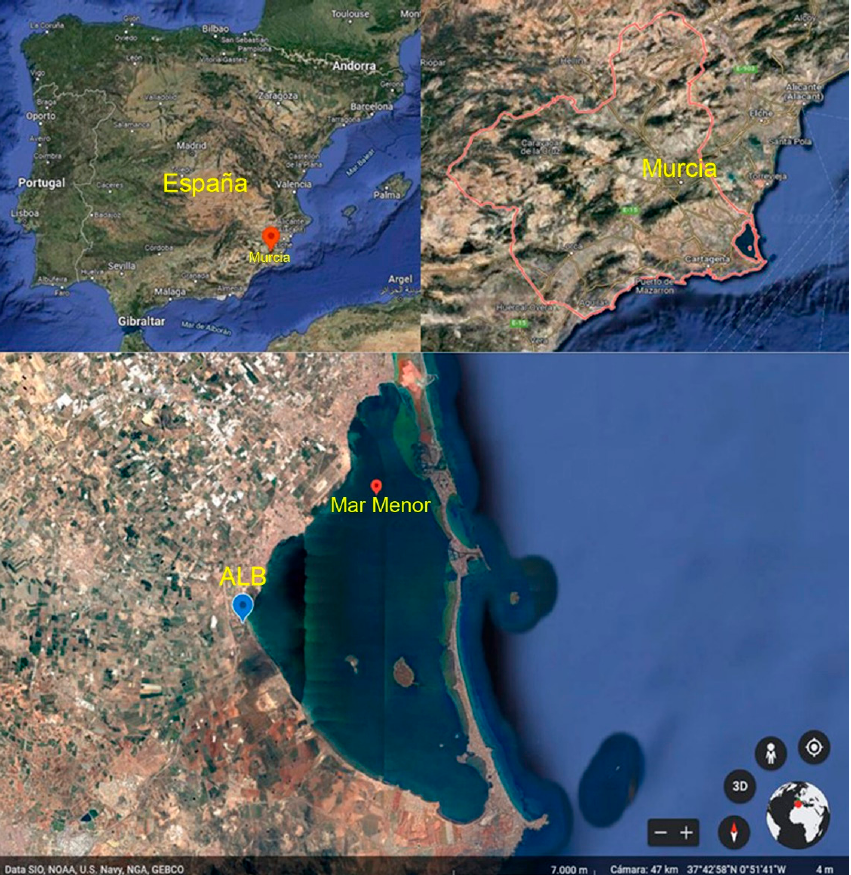
Figure 1. Situation of Region of Murcia and El Albujón watercourse. Adapted with permission from Ref [34]. Copyright 2022. Inst. Geograf. Nacional de España.